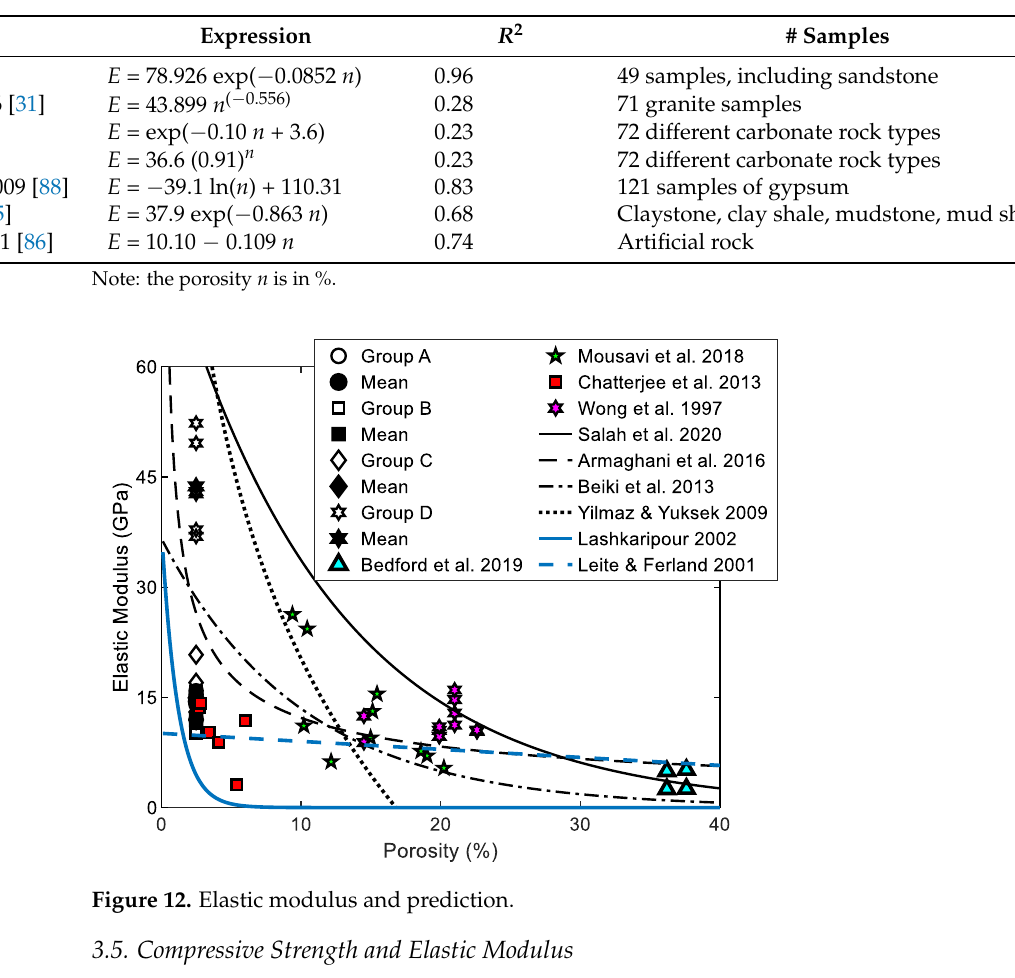
Table 8. Empirical expressions for elastic modulus prediction.